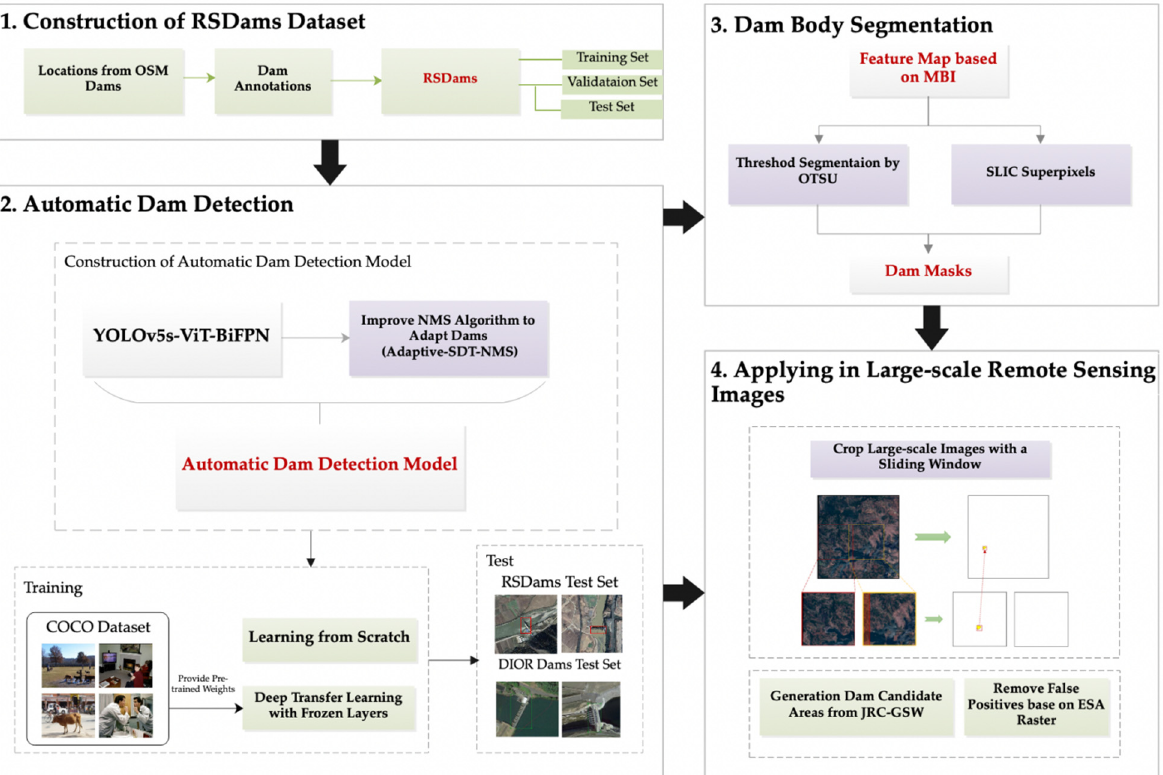
Figure 1. The workflow of the proposed method for dam extraction.